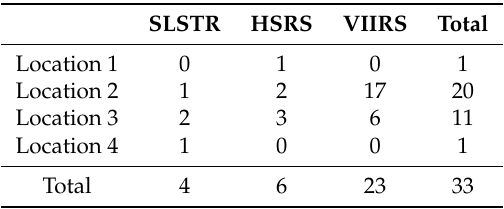
Table 4. Summary of the detections at the Bovanenkovo gas and condensates field in the Yamal Peninsula,